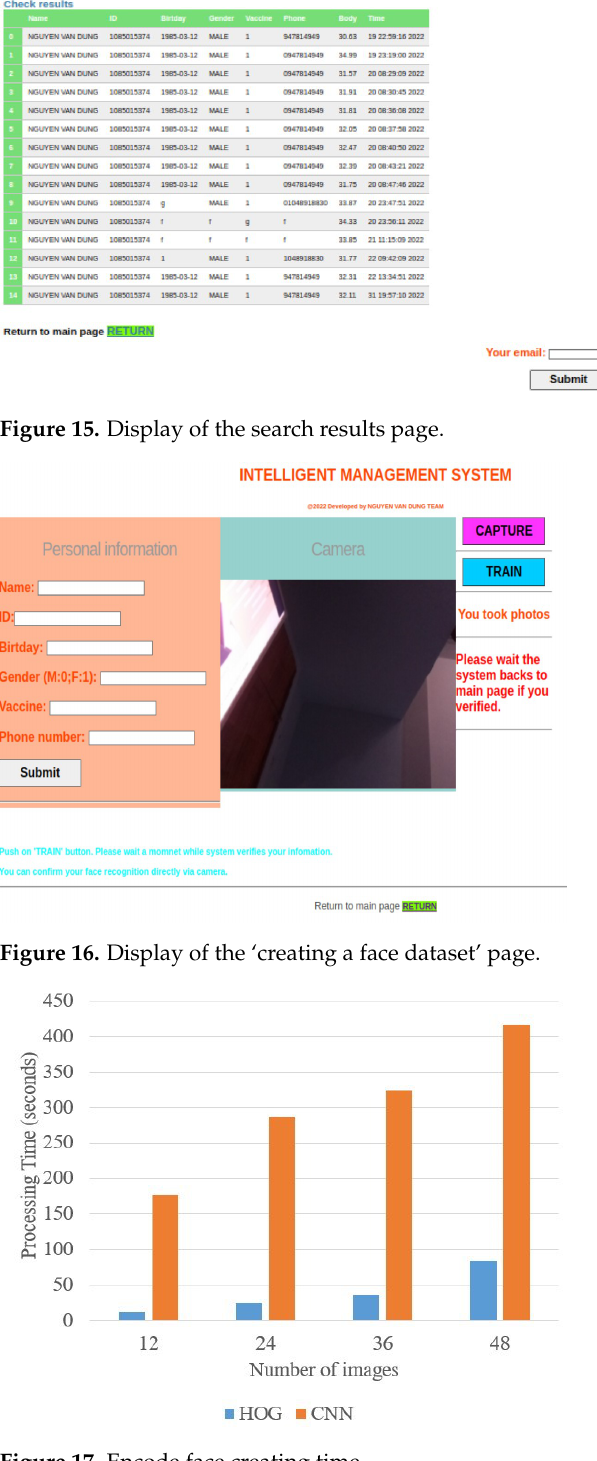
Figure 17. Encode face creating